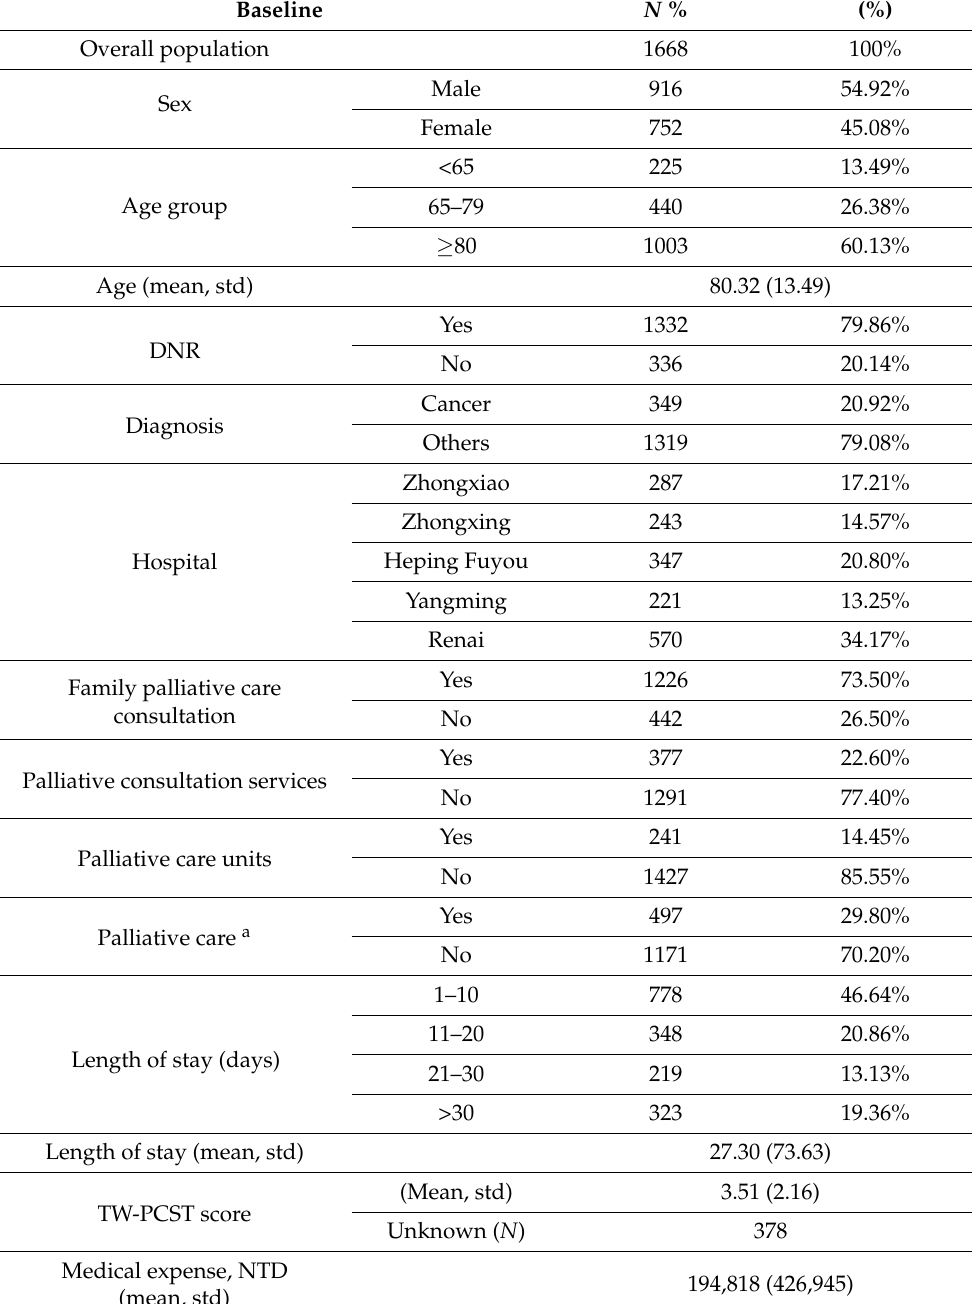
Table 1. Baseline